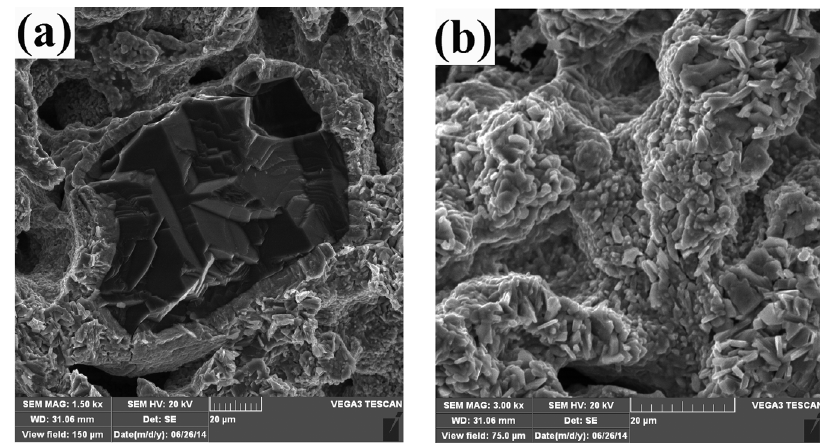
Figure 8: Fracture micrograph of the synthesized sample containing 80/100 mesh c-BN the morphology of (a) c-BN and (b) the